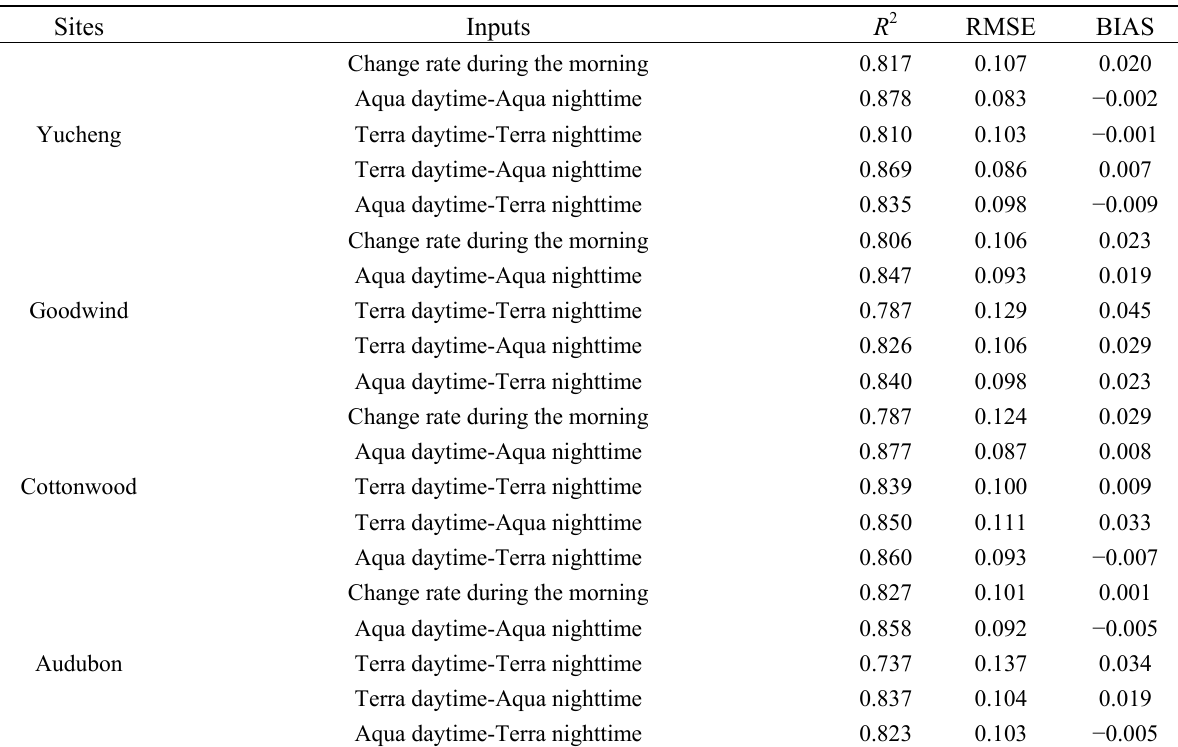
Table 2. Results from Equation (13) with different input schemes for ALEX-simulated data driven by different atmospheric conditions from four